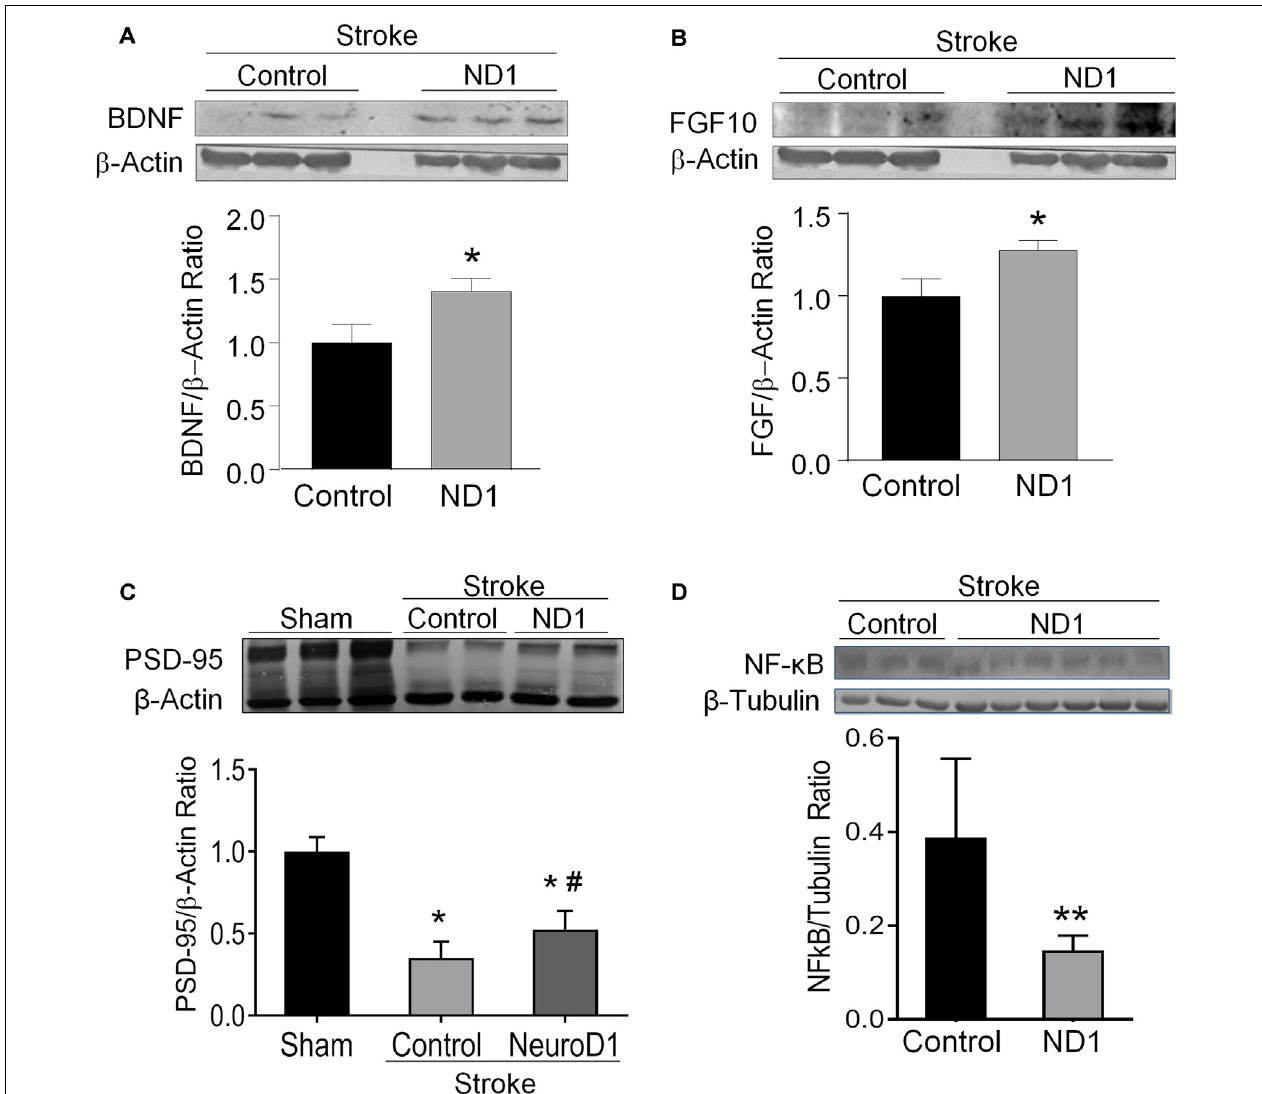
FIGURE 4 | Increased expression of regenerative genes and brain protection after ND1 treatment. Western blotting measured several key growth factors and synaptic proteins in the peri-infarcted region following stoke in control and ND1-treated animals 6 weeks after stroke. (A,B) The expression of BDNF (unpaired two-tailed Student’s t -test: n = 8/group, t = 2.305, * p < 0.05) and FGF (unpaired two-tailed Student’s t -test: n = 8/group, t = 2.407, * p < 0.05) were significantly increased in the brain subjected to ND1 vs. vehicle control of stroke mice. Panels (A,B) were performed in the same Western blot experiments with the same load control. (C) The expression of postsynaptic protein PSD-95 decreased after stroke and ND1 treatment partially recovered this synaptic protein loss. Two-way ANOVA (interaction: F (2,4) = 45.52, ∗∗∗ p = 0.0018 followed by Holm–Sidak’s Multiple Comparisons Test: * p < 0.05 vs. sham; # p < 0.05 vs. empty vector control). (D) The ND1 treatment significantly reduced the NF-kB level in the post-stroke brain (unpaired two-tailed Student’s t -test: n = 3 for vector control and n = 6 for ND1 group, t = 3.613, ** p <